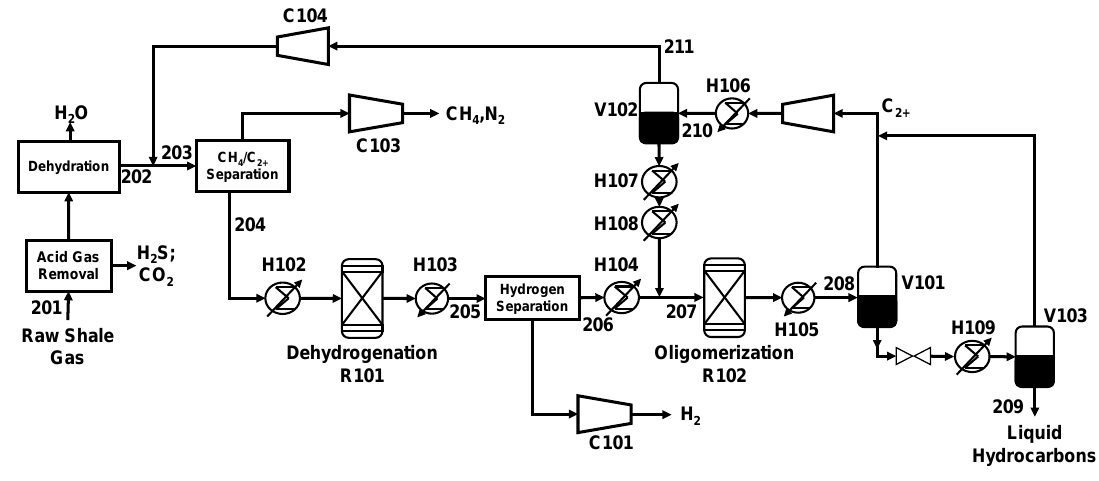
Figure 4. Process flow sheet for Process